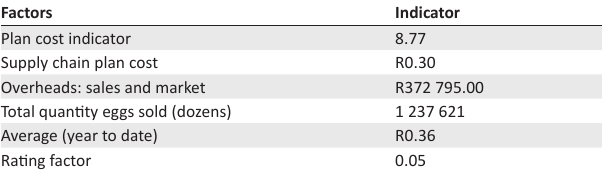
TABLE 21: Planning cost.